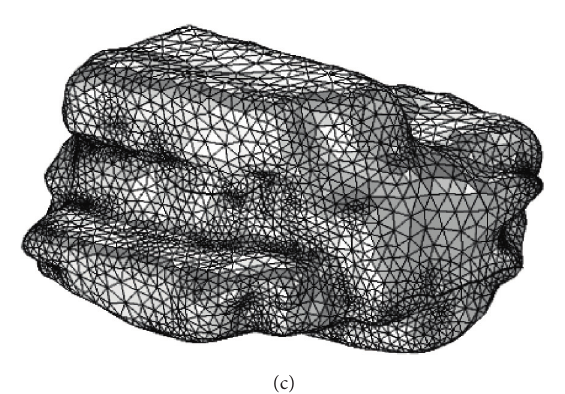
Figure 9: Geometric model processing of irregular cavities. (a) Encapsulation model. (b) Solid model. (c) Mesh generation.